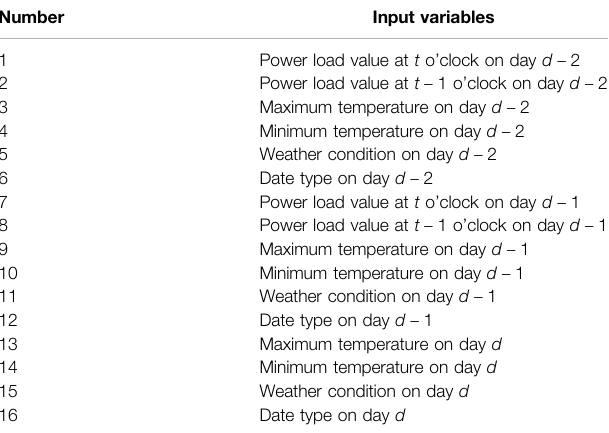
TABLE 1 | Input variables of the GRNN.